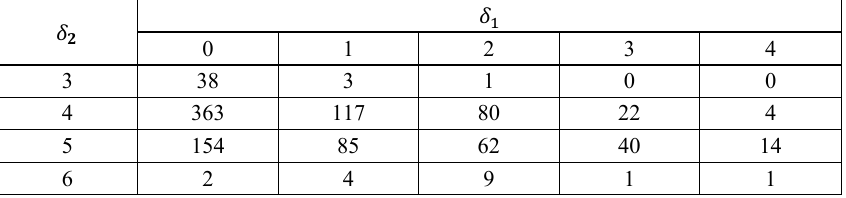
Table 2. Number of corresponding experimental samples when